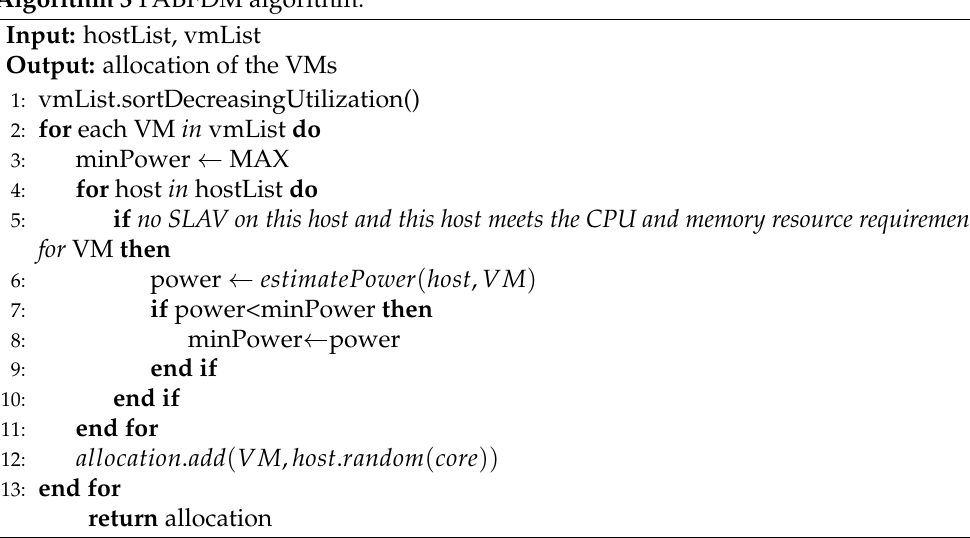
Algorithm 3 PABFDM